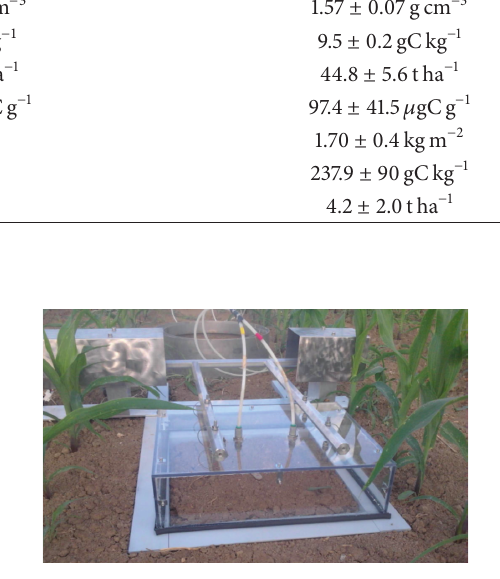
Figure 1: A chamber of the SASSFLUX